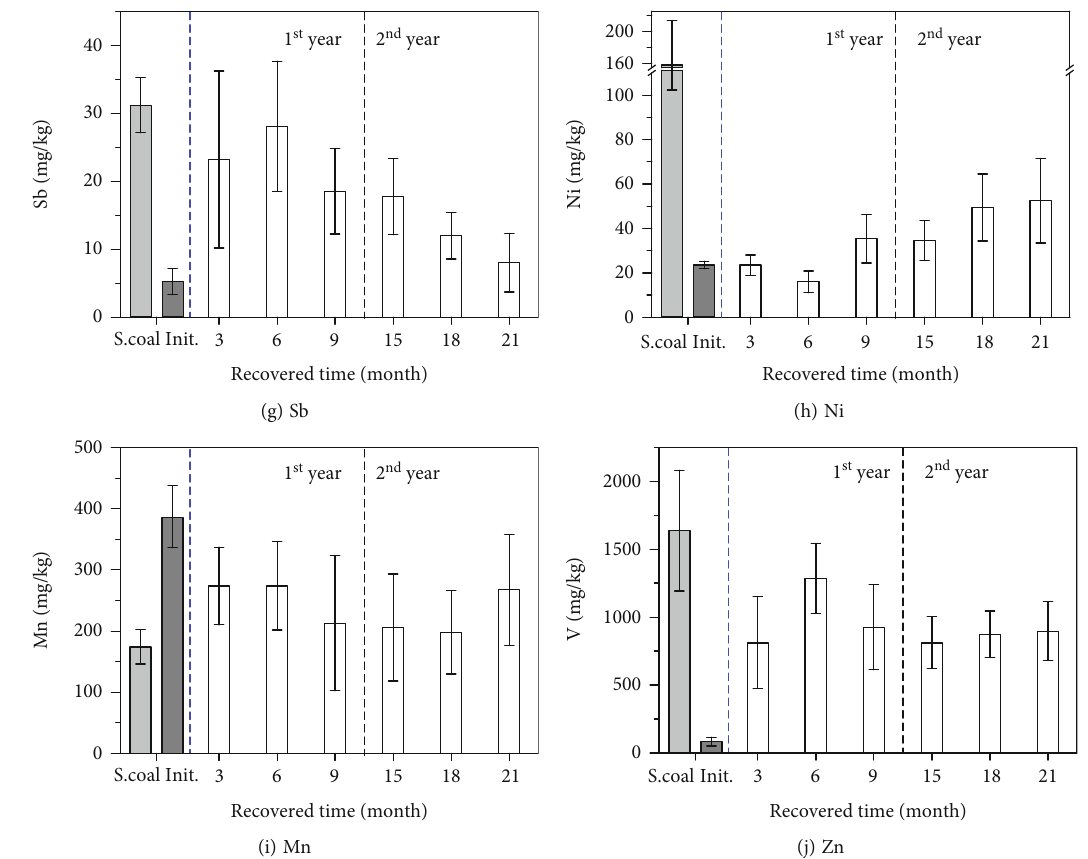
Figure 3: The concentrations of heavy metal of both stone coal and substrate material with recovered time. The s.coal and init. represented stone coal and substrate material, respectively. The error bar was the standard